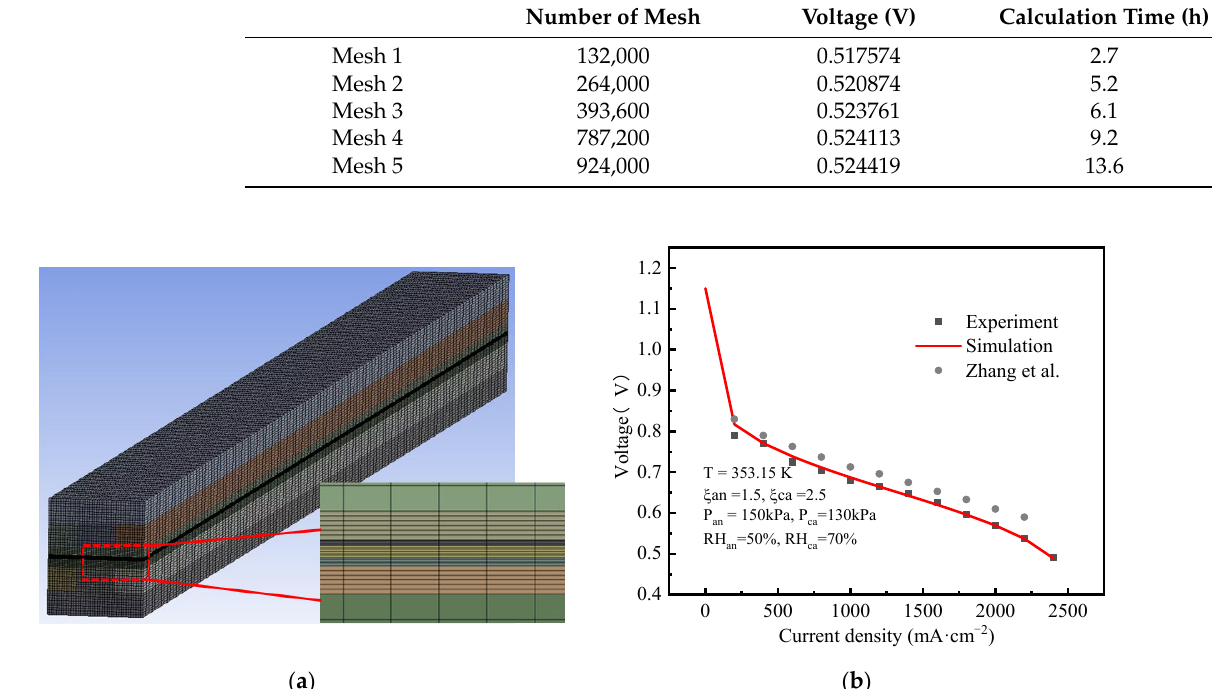
Figure 3. ( a ) Computational mesh used for the three cases, ( b ) Comparison of polarization curves between experiment and simulation and Zhang et al.